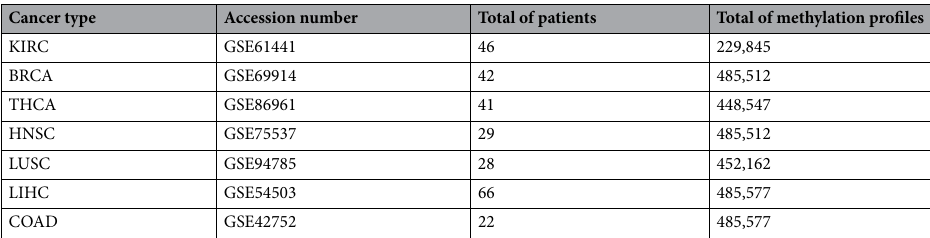
Table 4. The description of GEO datasets used in this study. KIRC kidney renal clear cell carcinoma, BRCA breast invasive carcinoma, THCA thyroid carcinoma, HNSC head and neck squamous cell carcinoma, LUSC lung squamous cell carcinoma, LIHC liver hepatocellular carcinoma, COAD colon